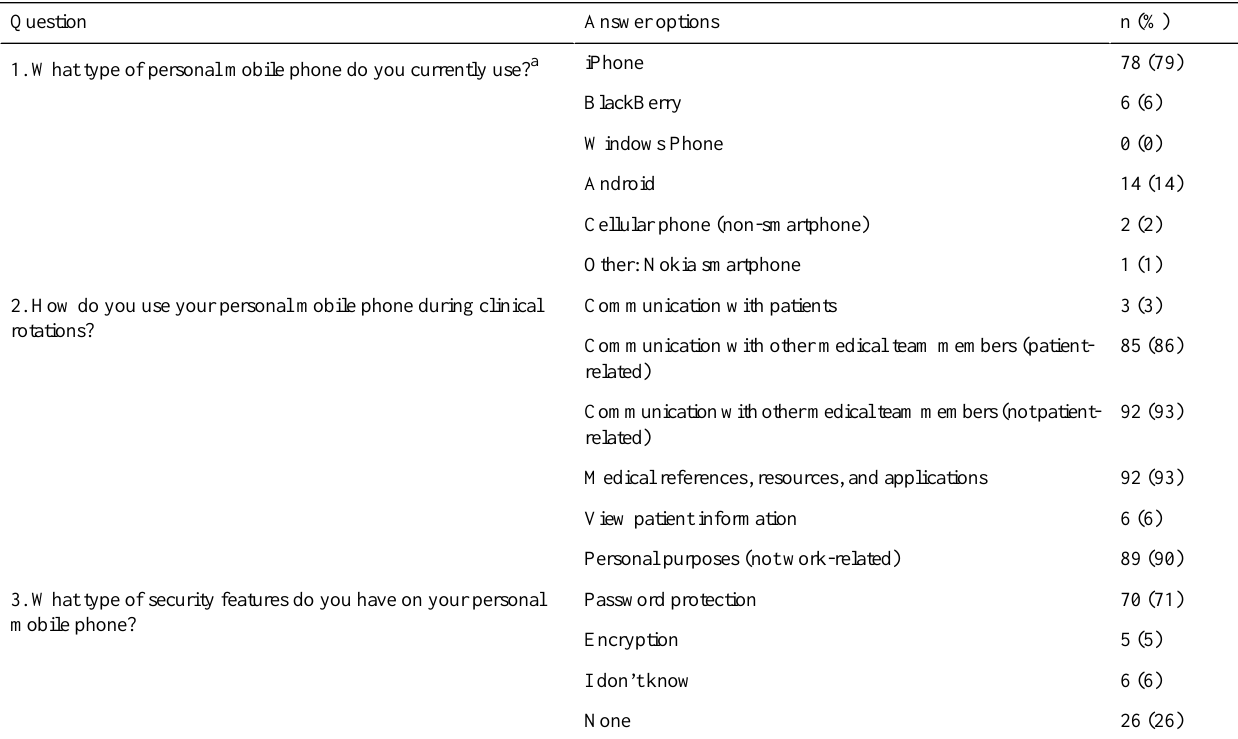
Table 1. The type, uses, and security features on medical students’personal mobile phones